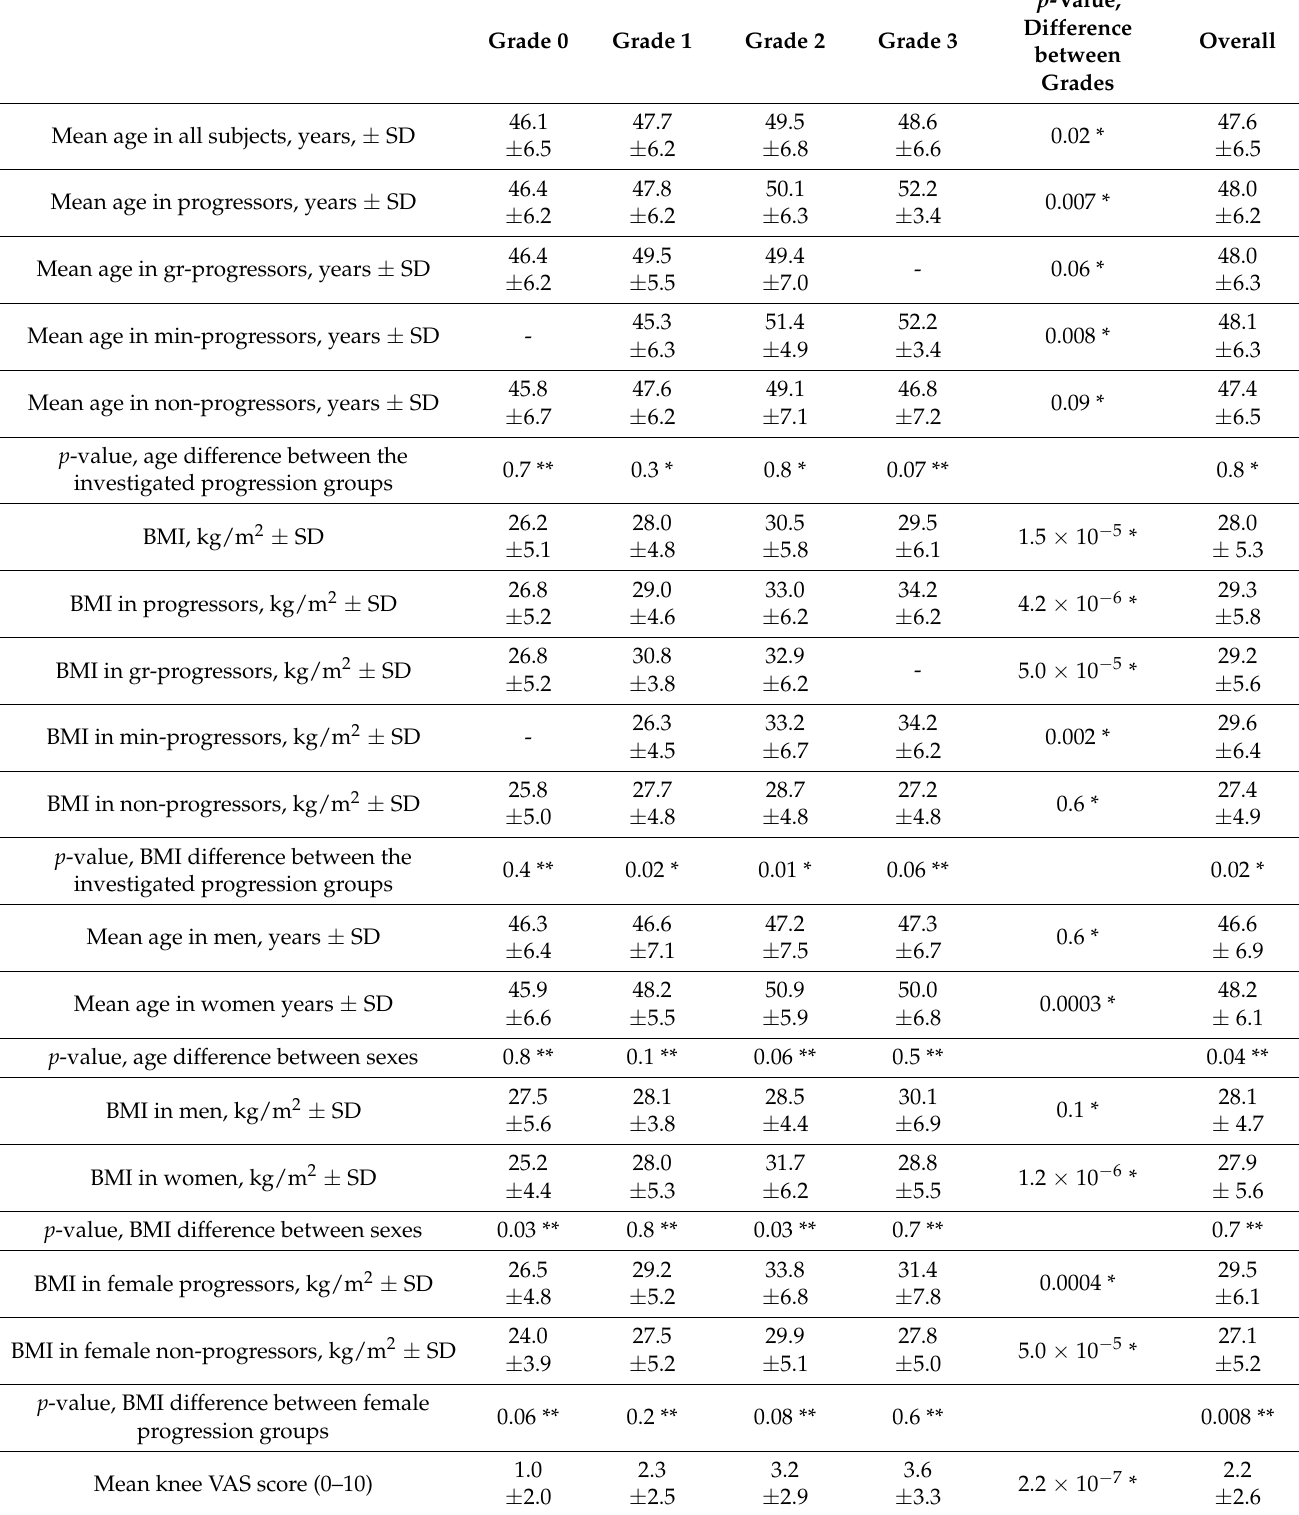
Table 2. Description of the study cohort divided by radiographic global grades of knee osteoarthritis (gOA).